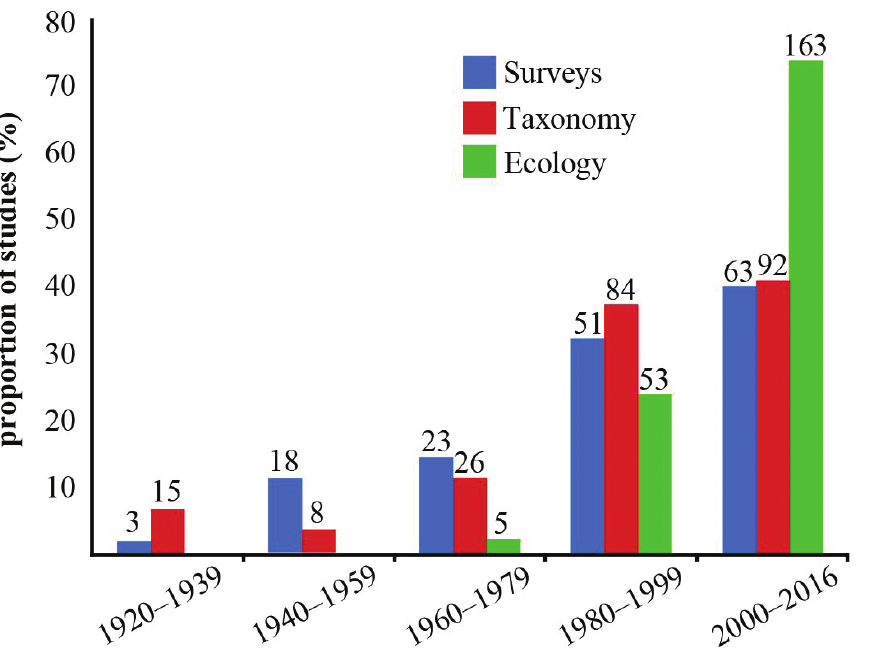
Figure 2. Proportion of articles on the fish cestodes from South America published per intervals of years sorted by categories. The numerals above individual bars indicate the absolute number of